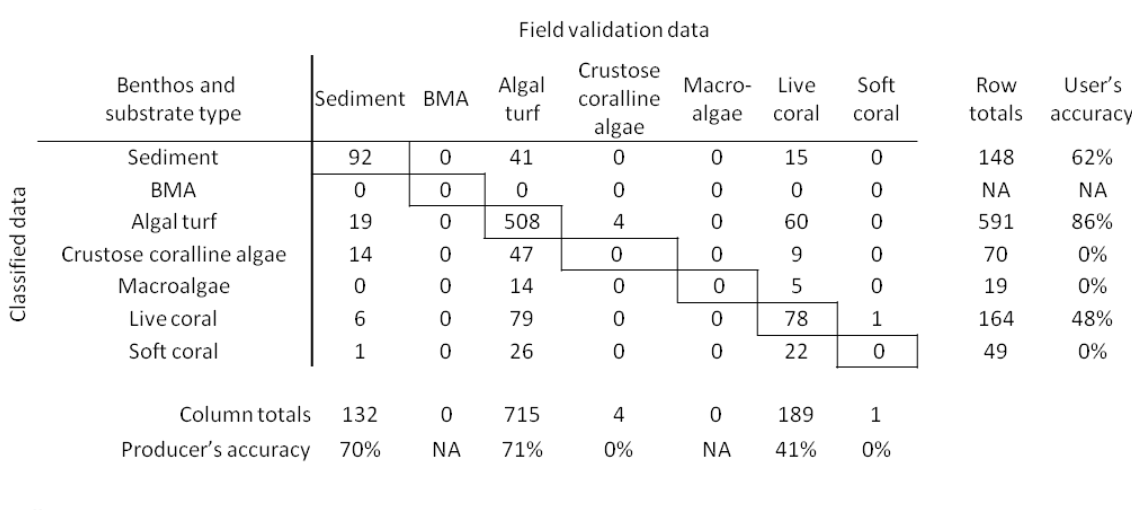
Figure 6. Standard error matrix. The three divisions of macro-algae (Brown, Red, and Green), and two modes of live coral (blue and brown), were grouped together to form a single macro-algae and live coral group, respectively. Overall accuracy was